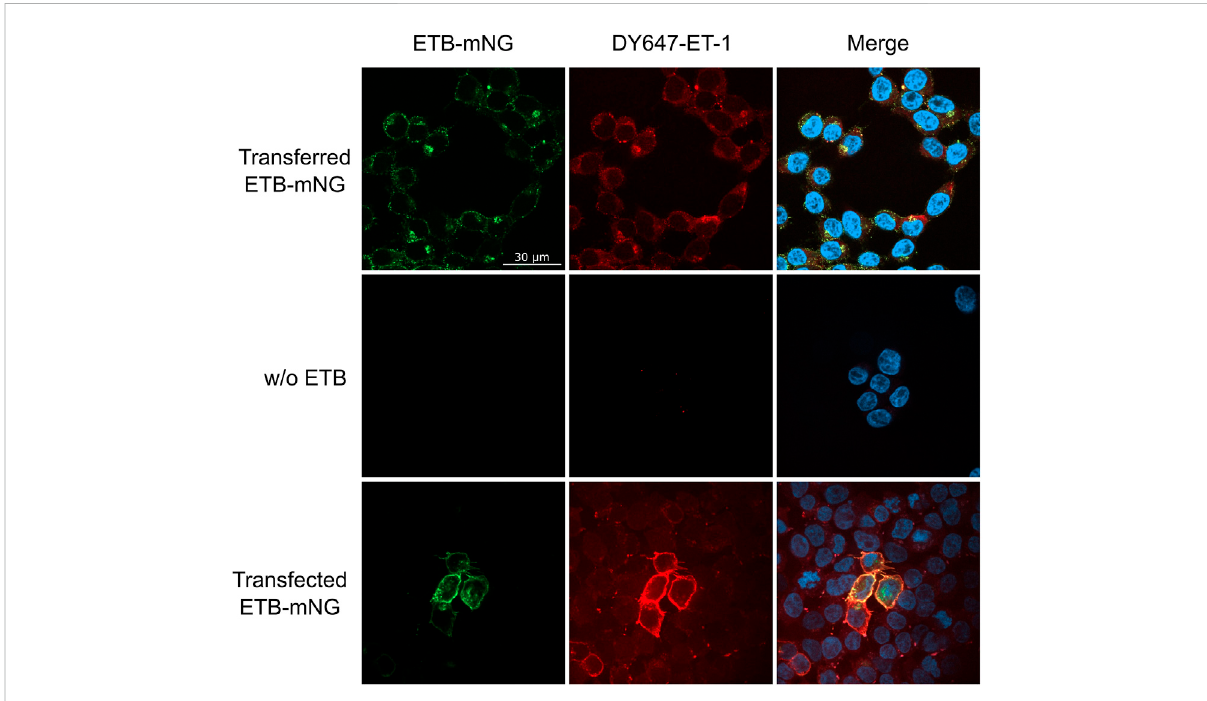
FIGURE 11 Ligand binding of transferred ETB-mNG in HEK293T cells. LAC-puri fi ed ETB-mNG was transferred into HEK293T cells at standard conditions. After washing, cells were incubated with 100 nM DY647-ET-1 for 1 h at 4 ° C. After additional washing, fl uorescence microscopy was performed and representative pictures were taken. Transfected HEK293T cells synthesizing ETB-mNG were used as a positive control.